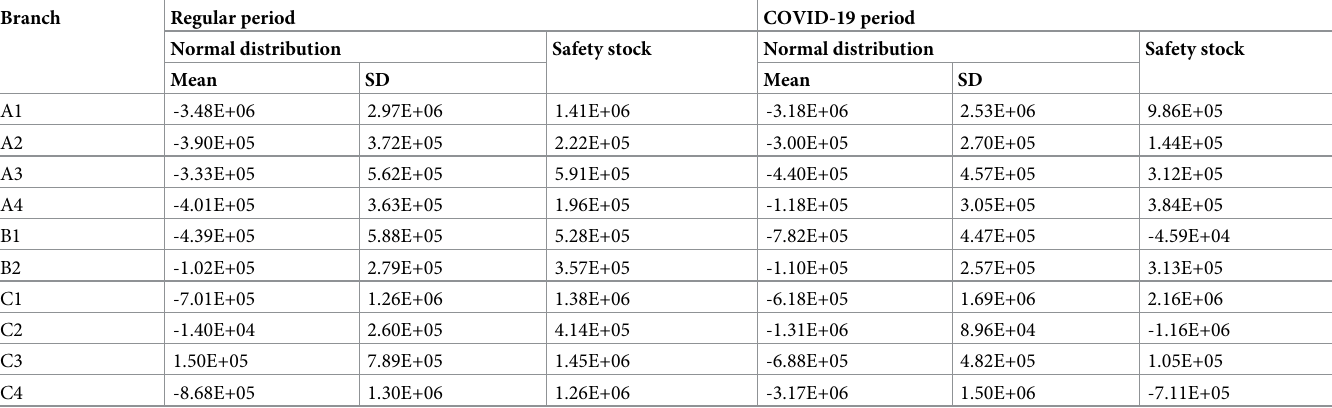
Table 11. Parameters of the normal distribution of the CO prediction errors and the inverse of their cumulative distribution at α = 0.05. Branch